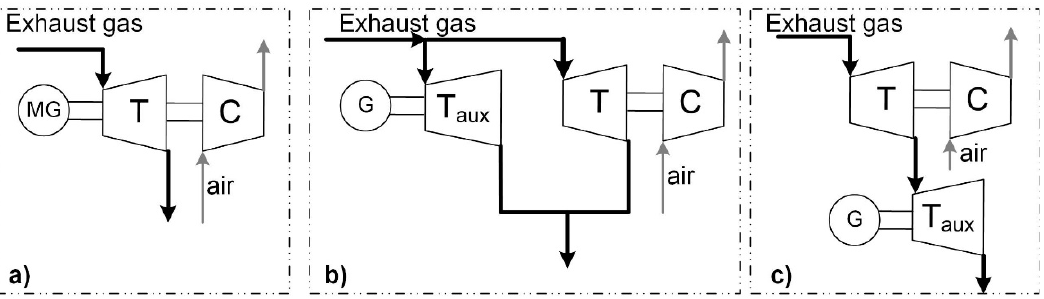
Figure 4. Direct expansion recovery configurations: ( a ) electrical motor-generator on turbocharging; ( b ) parallel turbine and ( c ) series turbine.